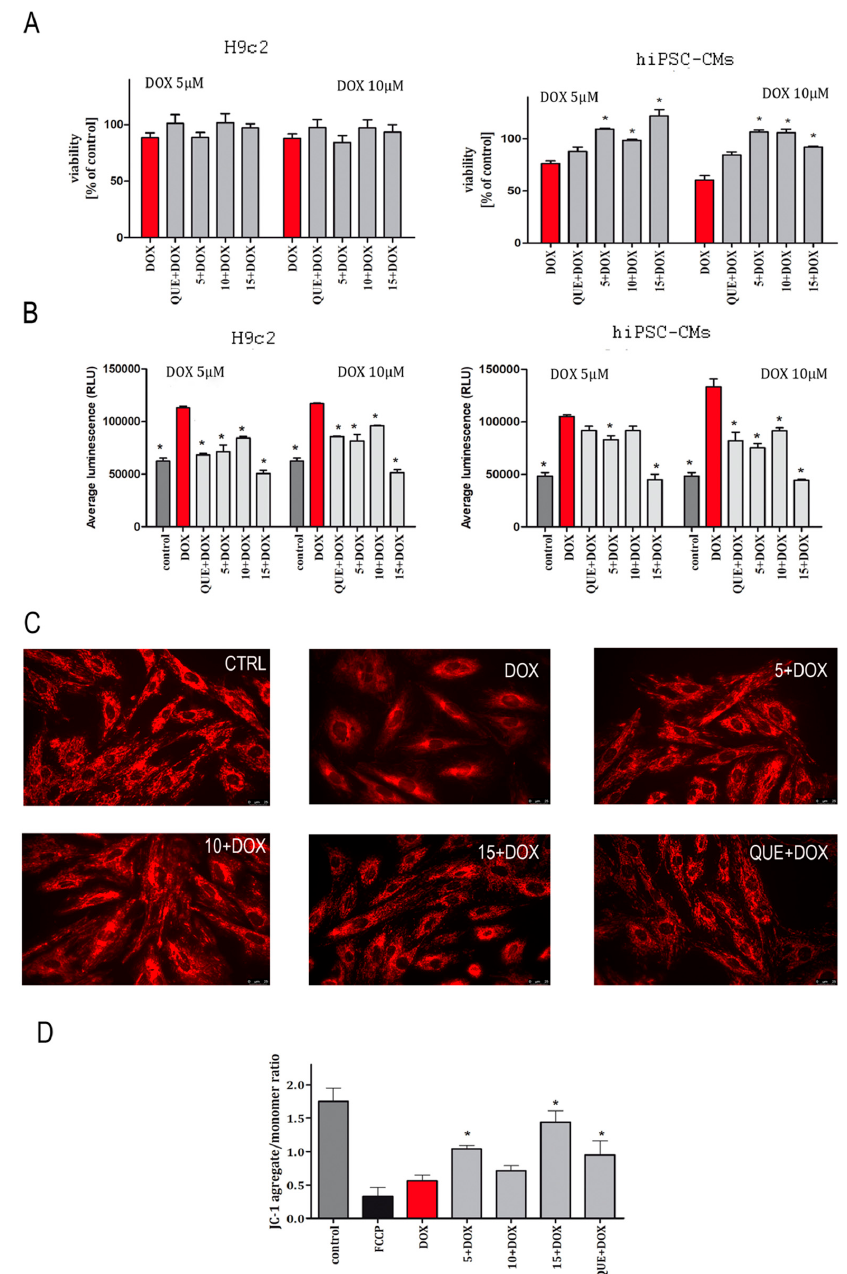
Figure 1. Protective effect of compounds 5 , 10 , and 15 against doxorubicin-induced cytotoxicity ( A ), oxidative stress ( B ), and mitochondrial damage ( C , D ). The study was performed in two cellular models: H9c2 and hiPSC-CMs. Cells were cultured with tested compounds— 5 , 10 , 15 (25 µ M), and quercetin (20 µ M)—as a reference standard for 5 h. Then, the medium was removed, cells were incubated with doxorubicin (DOX, 5 or 10 µ M) for 90 min, and the MTT ( A ) or ROS-Glo™ H 2 O 2 ( B ) assays were performed. Values represent the viability of cells in the percentage of control (untreated cells) ± SEM of six replicates of three independent experiments ( A ) or average RLU (relative light unit) ± SEM of six replicates of three independent experiments ( B ). The RLU value increases in direct proportion to the level of oxidative stress generated by the cells. Statistical significance (*) was calculated relative to DOX ( p < 0.05). The effect of cinnamic acid derivatives and doxorubicin (CA–DOX) co-treatment on mitochondrial morphology was analyzed via fluorescent photomicrographs representing MitoTracker fluorescent staining of H9c2 cells ( C ). Bar graph representing JC-1 fluorescent mitochondrial depolarization of H9c2 cells’ membrane potential after CA–DOX treatment. Data are represented as two independent biological experiments, each with four technical replicates ( n = 8). Results are expressed as the mean ± SEM ( D